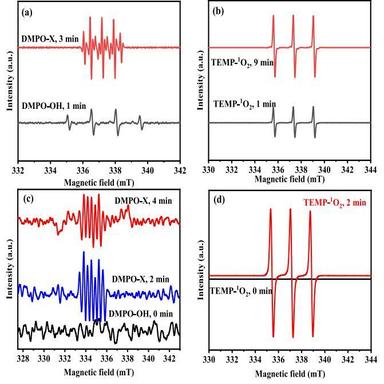
EPR results of the 5%Cu2+-Co3O4/NC-glycerol-600 (a, b) and 5%Cu2+- Co2AlO4/NC-glycerol-600 (c, d) catalysts. Experimental conditions: 0= 0.05 g/L, 0= 1.8 mM, 0= 12.5 mg/L, initial pH= 9, temperature = 25 ◦C, = 26 mM, = = 1.3 M, = 150 mM, = 18 mM.